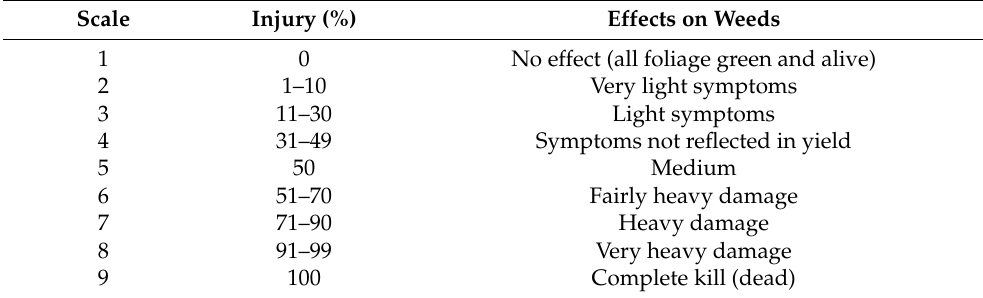
Table 6. Injury rating scale